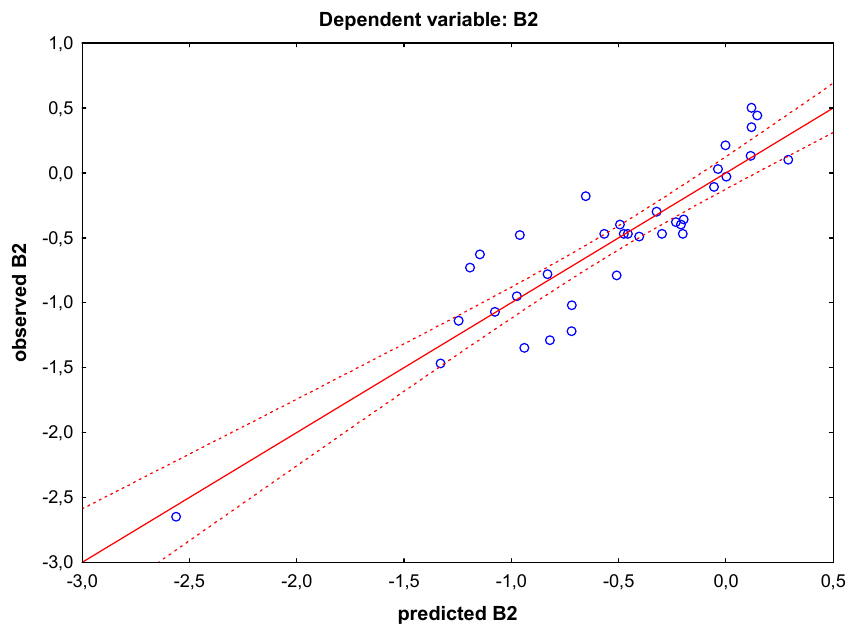
Figure 1. Scatter plot of the relationships between the predicted and observed variables B2 in the MLR model.